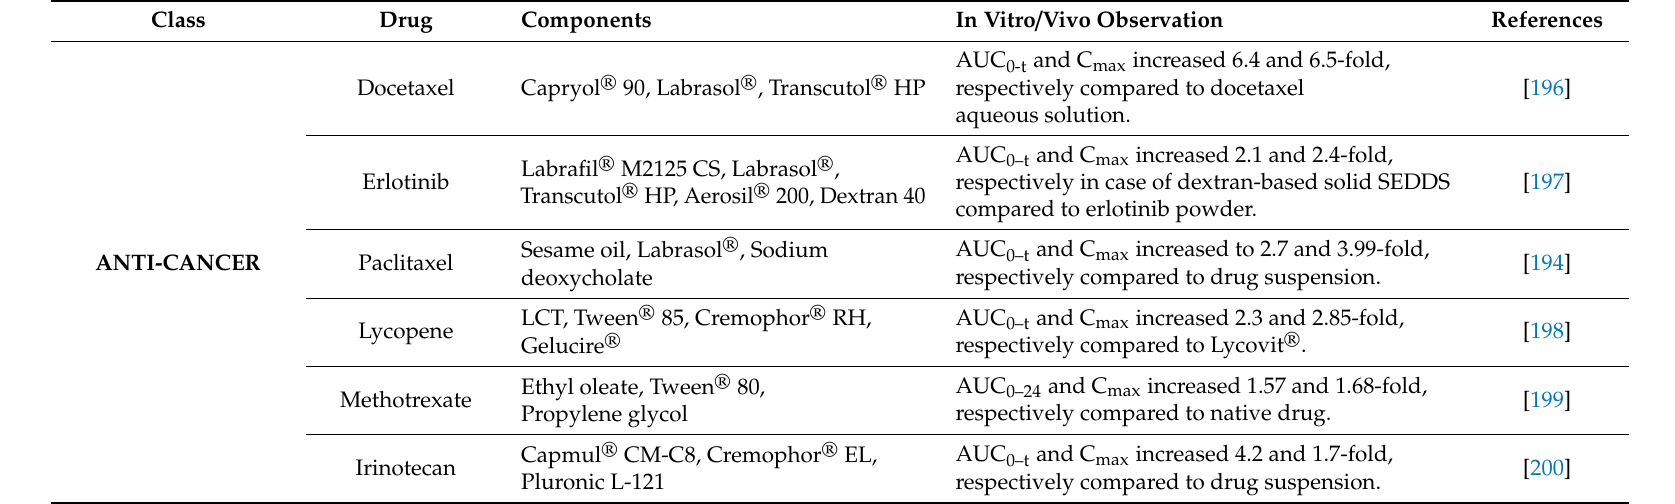
Table 3. Examples of preclinical studies reporting enhanced dissolution and bio-availability of drugs upon their incorporation into